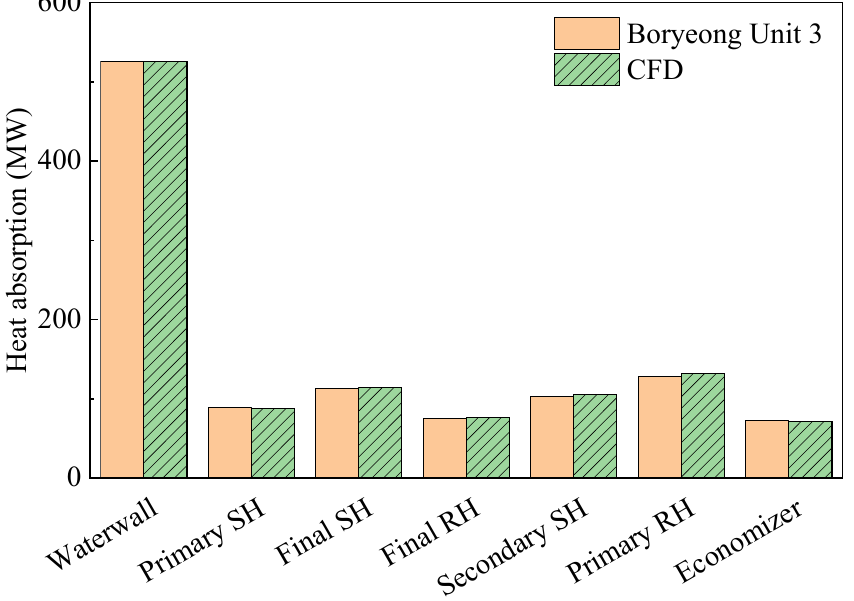
Figure 5. Validation for heat absorption of each heat exchanger component. CFD: computational fluid dynamics; SH: superheater; RH: reheater.